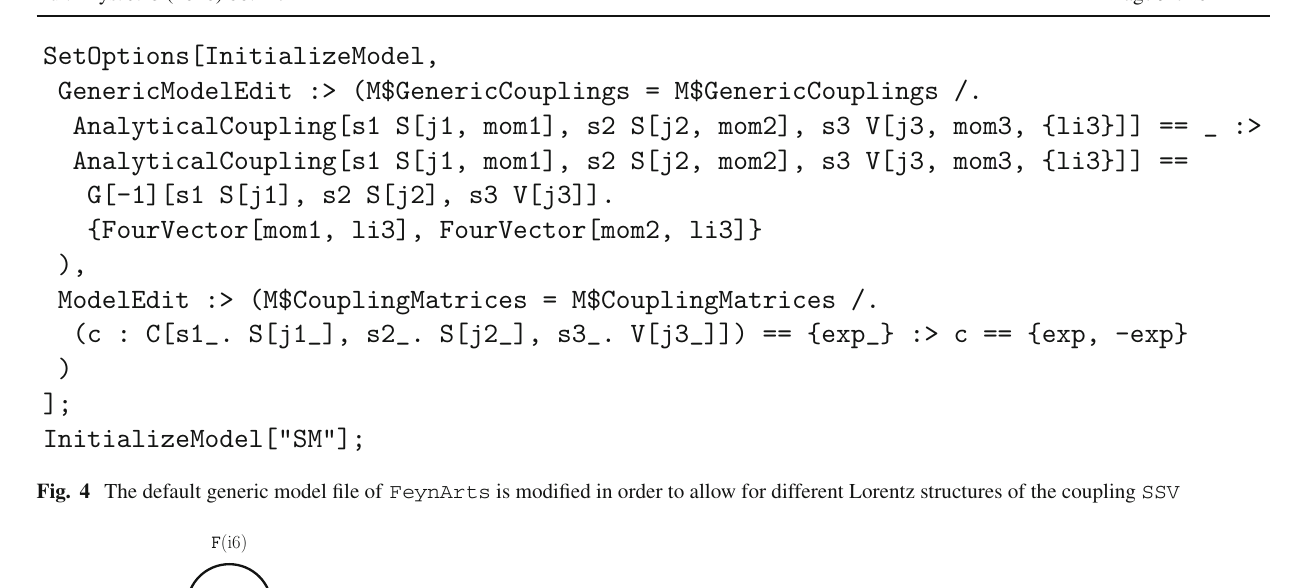
the other edges and labelled iv[ i ] . If the starting and ending vertices of an edge are interchanged compared to their original description in FeynArts , the propagator index receives a sign, indicating an antipar- ticle on that